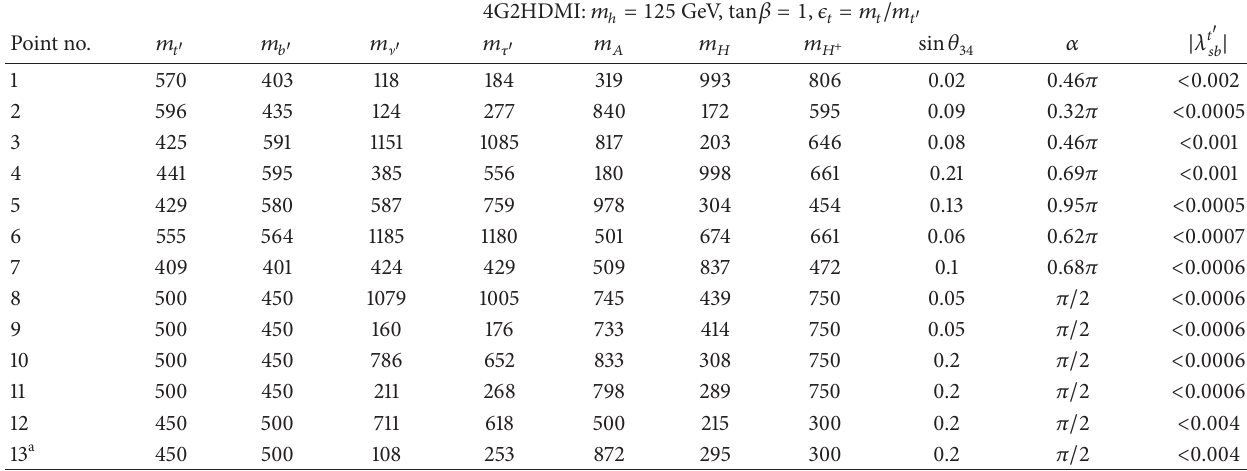
Table 2: List of points (models) in parameter space for the 4G2HDM’s of type I with 𝑚 ℎ = 125 GeV, tan 𝛽 = 1, and 𝜖 𝑡 = 𝑚 𝑡 /𝑚 𝑡 󸀠 , allowed at 95% CL by EWPD and B-physics flavor data. Points 1-2 have 𝑚 𝑡 󸀠 −𝑚 𝑏 󸀠 > 150 GeV, while points 3–5 have a large inverted splitting 𝑚 𝑏 󸀠 −𝑚 𝑡 󸀠 > 150 GeV. Points 6 and 7 have nearly degenerate 4th generation quark and lepton doublets. Points 8–11 give BR (𝑡 󸀠 → 𝑡ℎ) ∼ O (1) (see Figure 16 in Section 5), while points 12 and 13 give BR (𝑏 󸀠 → 𝑡𝐻 + ) ∼ O (1) (see Figure 17 in Section 5). Point 4 has a light 180GeV pseudoscalar Higgs ( 𝐴 ) and points 12 and 13 have a light 300GeV charged Higgs. Points 1, 8, and 9 have a small 𝑡 󸀠 − 𝑏/𝑡 − 𝑏 󸀠 mixing angle ( 𝜃 34 ≤ 0.05 ), while points 4 and 10–13 have a Cabibbo size 𝑡 󸀠 − 𝑏/𝑡 − 𝑏 󸀠 mixing angle ( 𝜃 34 ∼ 0.2 ). 4G2HDMI: 𝑚 ℎ = 125 GeV, tan 𝛽 = 1 , 𝜖 𝑡 = 𝑚 𝑡 /𝑚 𝑡